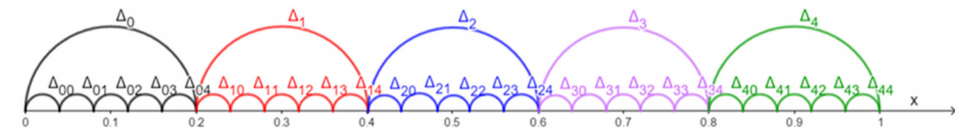
Figure 6. Q-cylinders of the 1st and 2nd rank.